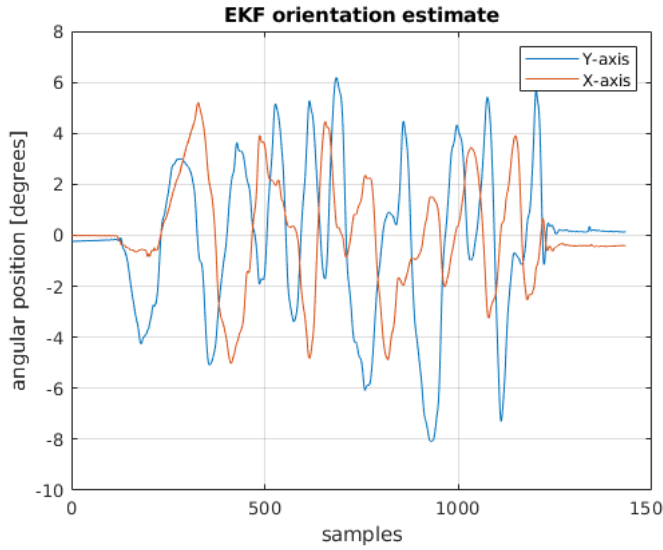
Figure 12. Position estimation using the EKF.